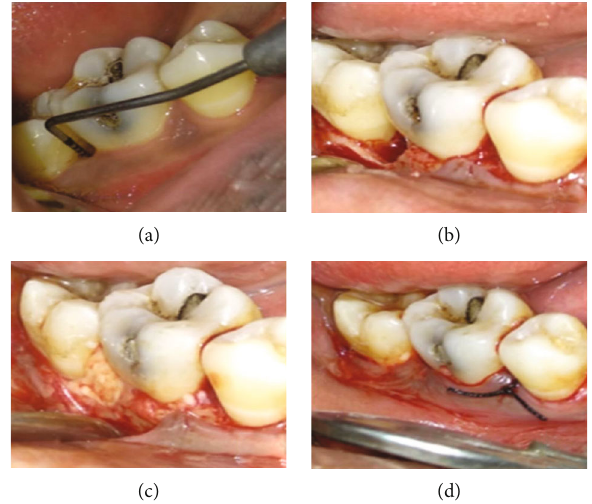
Figure 3: (a) PPD-10 mm. (b) Debridement done. (c) Placement of bovine colostrum. (d) Suturing done.